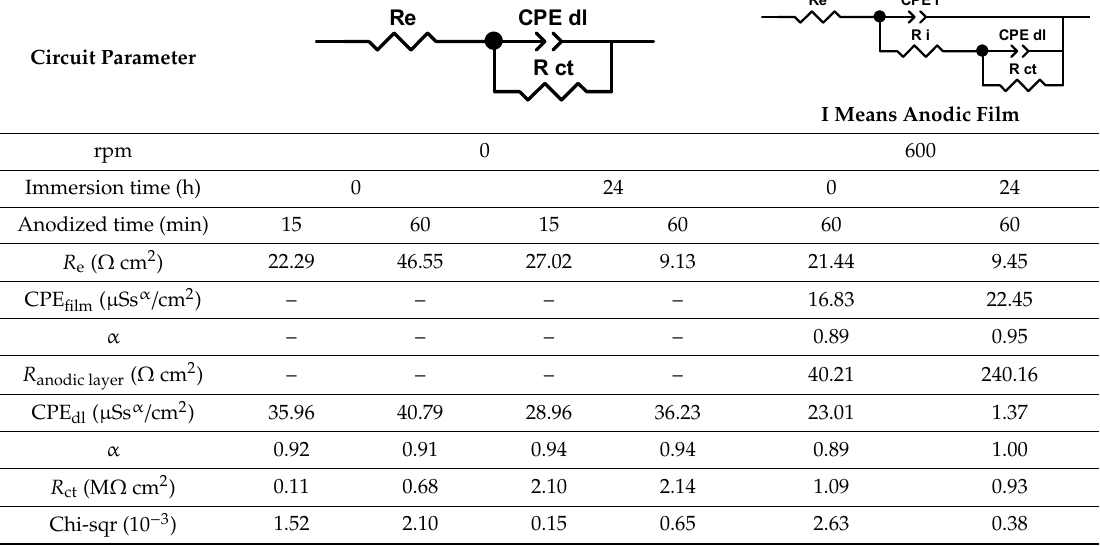
Table 3. Values of the electrical parameter of the equivalent circuit used to fit the spectra of the anodic films for different anodizing times and stirring speeds.